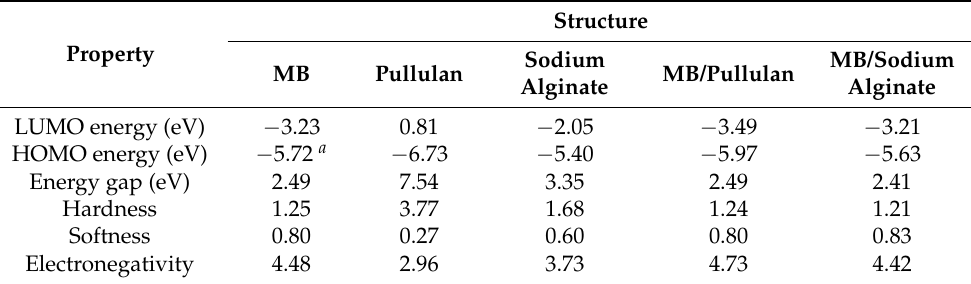
Table 6. Reaction parameters for methylene blue (MB) and its complexes with pullulan or sodium alginate obtained via the frontier orbital analysis at the B3LYP/6-31g(d) level of